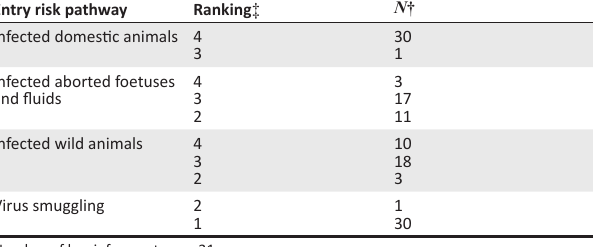
TABLE 1: Summarised results for qualitative ranking of Rift Valley fever risk factors in cattle as perceived by the pastoralists’ key informants in Ijara, Kenya. Risk factor